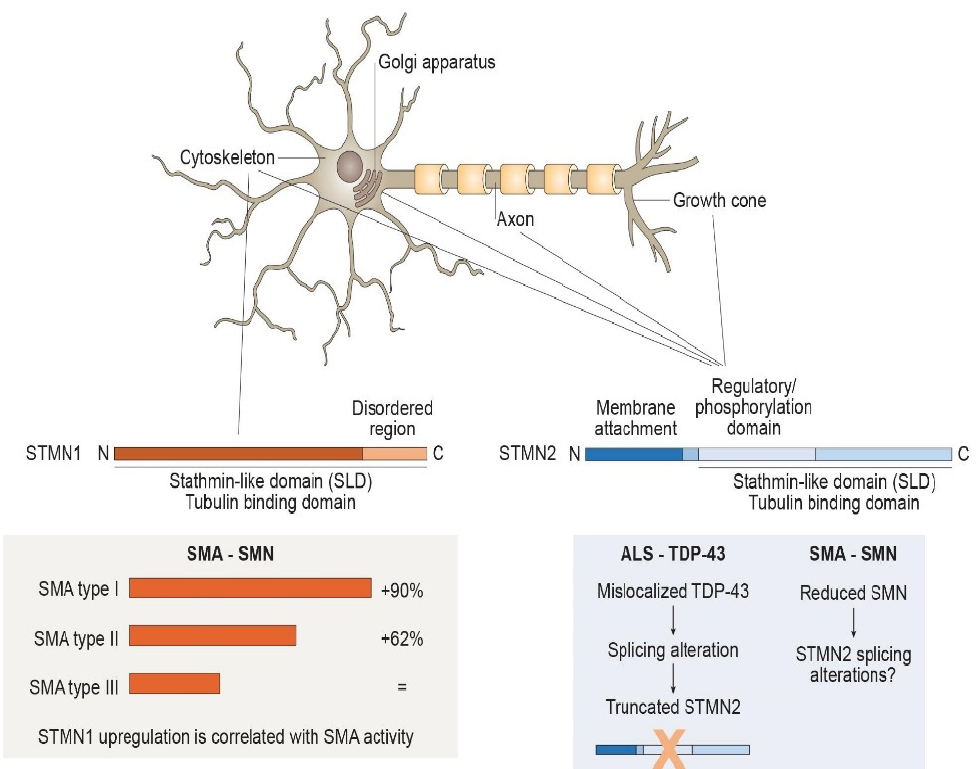
Figure 1. Structure, localization and regulation of Stathmin-1 (STMN1) and Stathmin-2 (STMN2). Stathmins regulate microtubule dynamics through phosphorylation-mediated binding of tubulin dimers with the C-terminal “stathmin-like domain” (SLD). STMN1 has a widespread cytosolic distribution, lacking the hydrophobic N-terminus. STMN1 protein levels are likely to be related to the presence of survival motor neurons (SMNs), since they are increased in spinal muscular atrophy (SMA) and seem to be correlated with disease severity. STMN2 presents hydrophobic residues at N-terminus that mediate its localization into intracellular membranes at the Golgi apparatus, associated with vesicles along the axons and within growth cones. STMN2 expression is regulated by transactive response DNA-binding protein 43 KDa (TDP-43), the mislocalization of which in amyotrophic lateral sclerosis (ALS) leads to STMN2-splicing alteration. STMN2 transcription and splicing could also be influenced by SMN considering its functional analogy with TDP-43 and, therefore, be involved in SMA pathogenesis.